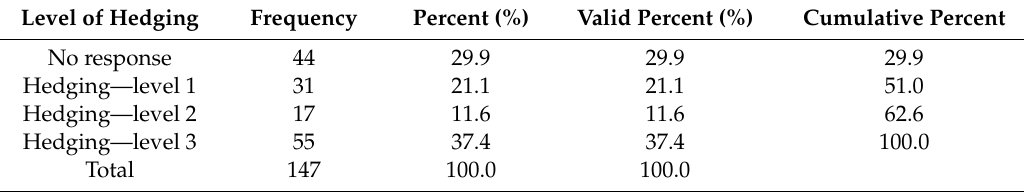
Table 3. Distribution of Kuwaiti firms according to their level of